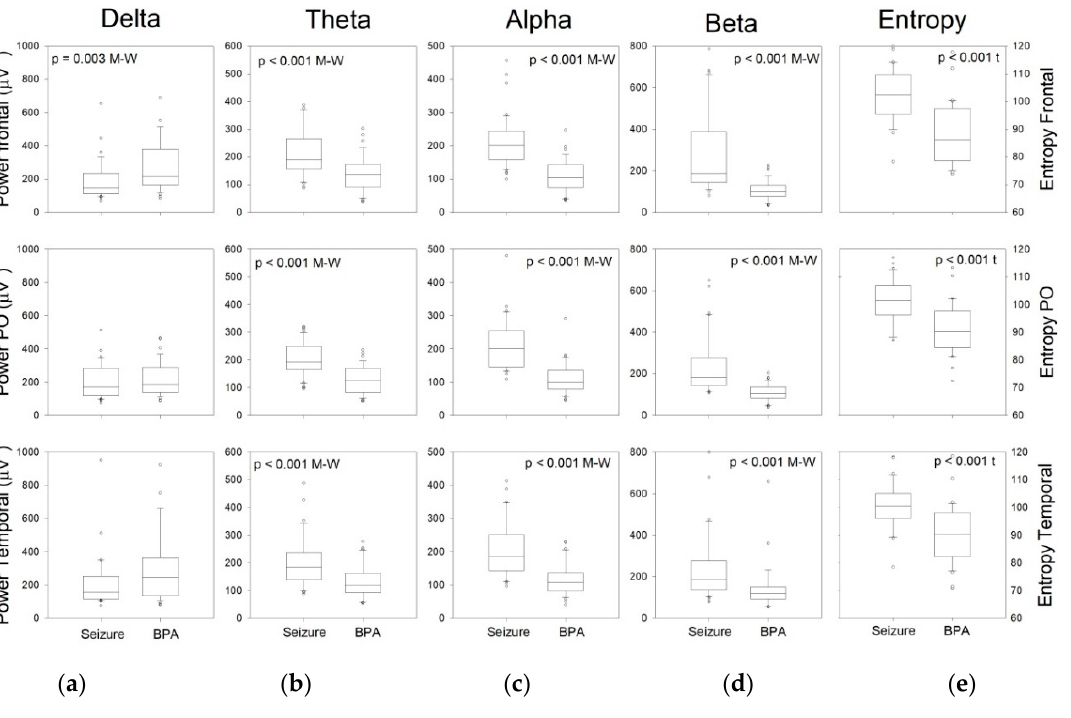
Table 3. Inter-percentile 25–75 intervals for bands and lobes in BPA and ES. Superposition is indicated with respect to ES interval.